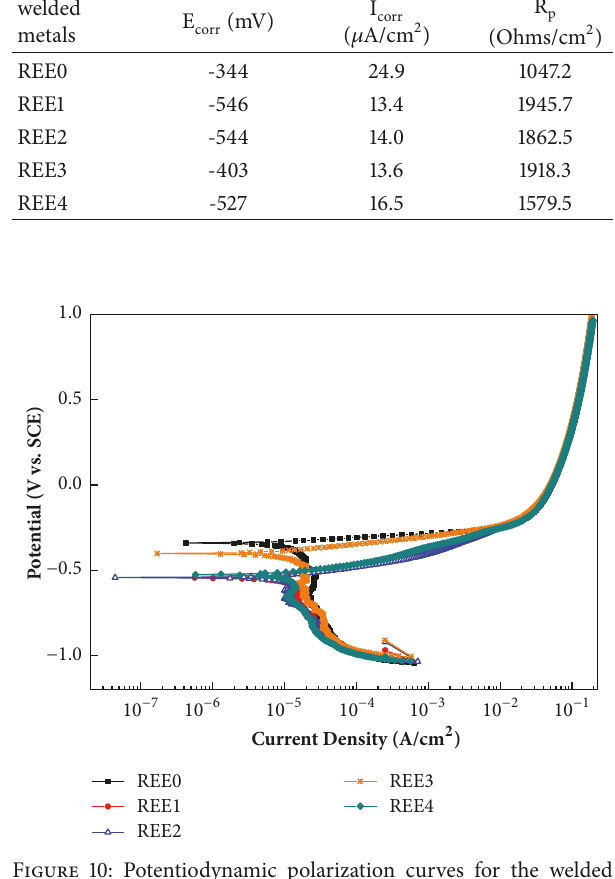
Figure 10: Potentiodynamic polarization curves for the welded metals with different REE